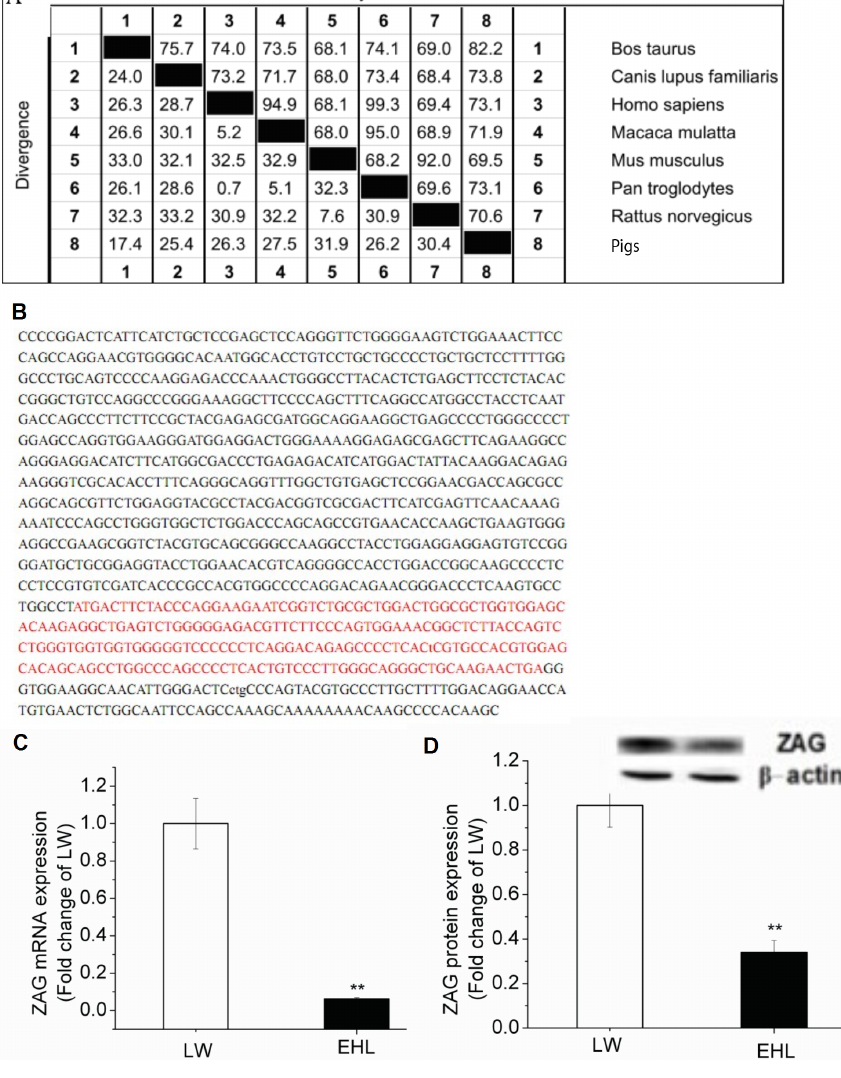
Figure 4. Porcine ZAG gene sequencing and its mRNA and protein expression between LW and EHL pigs. (a) Homology analysis, (b) porcine ZAG cDNA sequence, (c) ZAG mRNA expression and (d) ZAG protein expression. The values shown represent the mean ± standard error, n = 6; ** P <0.01 vs.